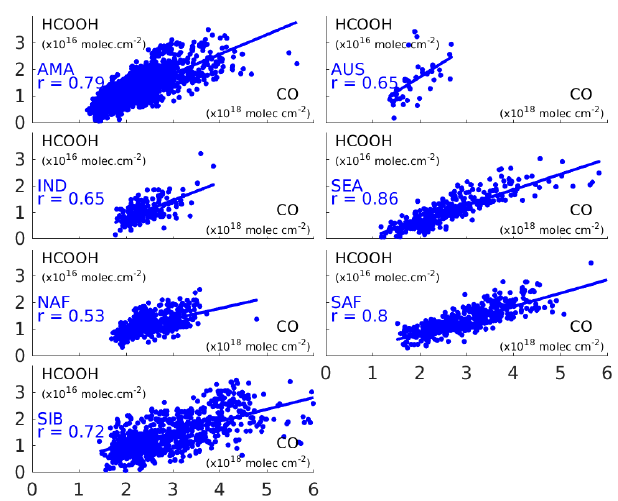
Figure 4. Scatterplots between the IASI fire-affected HCOOH total columns (in 10 16 moleccm − 2 ) and the CO total columns (in 10 18 moleccm − 2 ) over the seven regions (AMA = Amazonia, AUS = Australia, IND = India, SEA = Southeast Asia, NAF = northern Africa, SAF = southern Africa, SIB = Siberia). The linear regression is represented by the blue line and the correlation coefficient is also provided for each